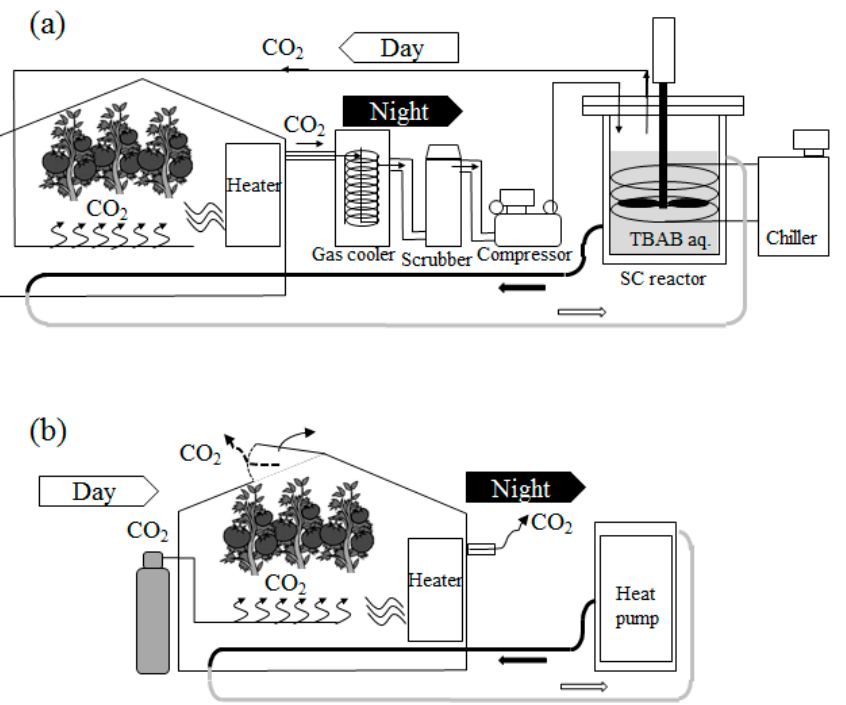
Figure 6. Configuration of CO 2 enrichment system, using ( a ) TBAB + CO 2 SC and ( b ) CO 2 gas from a tank.